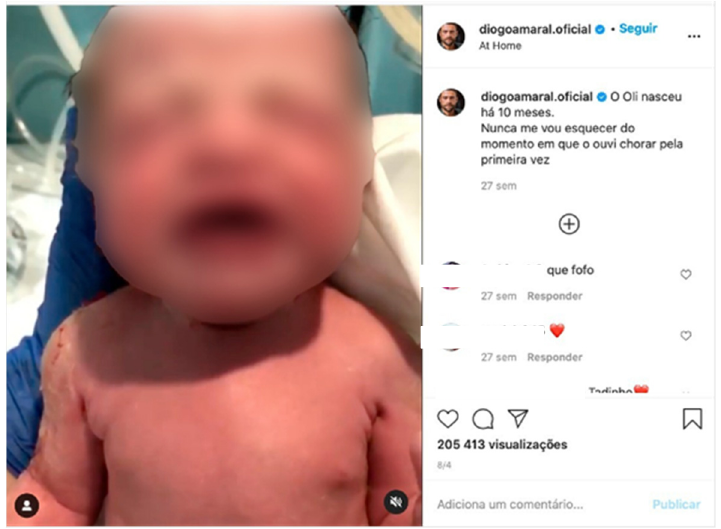
Figure 3. Example of “Special Events”; Instagram @diogoamaral.official, Post, 8 April 2020.